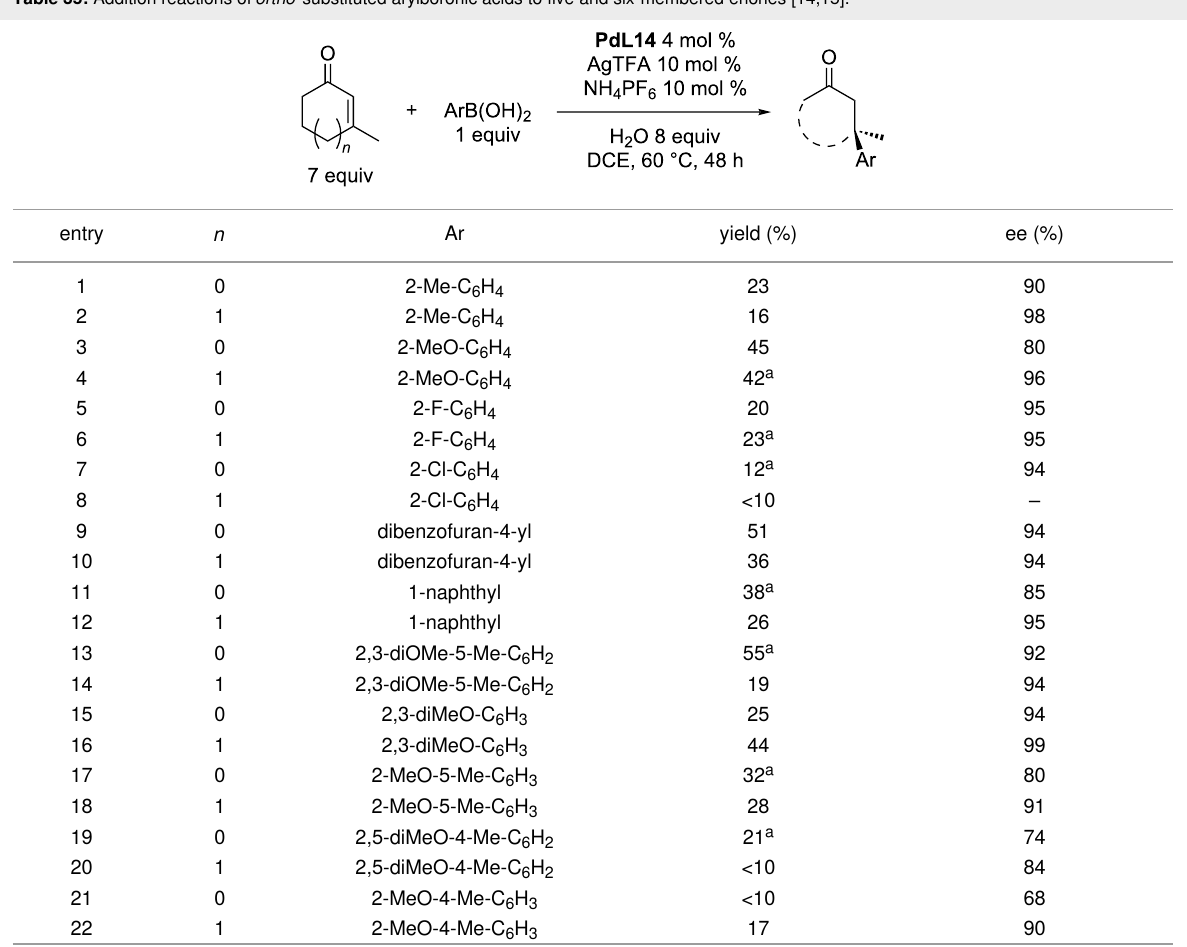
Table 35: Addition reactions of ortho -substituted arylboronic acids to five and six-membered enones [14,15].